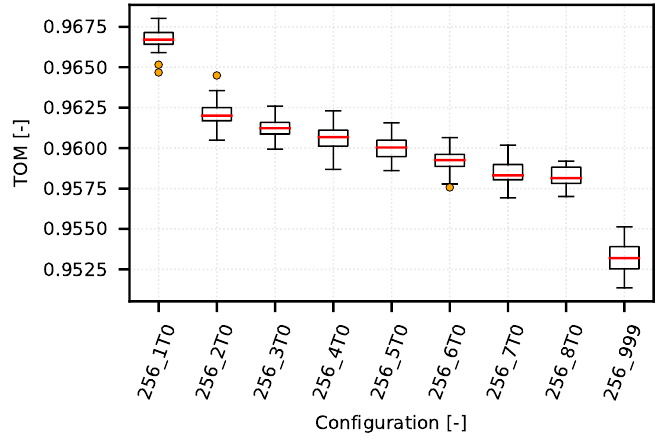
Figure 9. CSMA/CA—example of optimization curve (mean quantile 0.96 of 256_5T0 configurations).